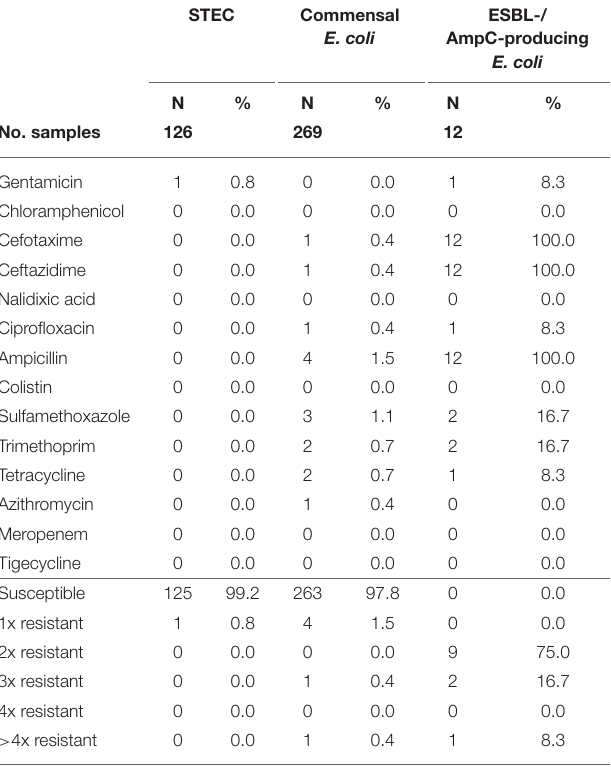
TABLE 6 | Number and proportion of tested resistant isolates from roe deer and TABLE 5 | Number and proportion of tested resistant isolates from wild boars and the number of substance classes to which the isolates were resistant. the number of substance classes to which the isolates were resistant. Salmonella STEC Commensal ESBL-/ STEC Commensal ESBL-/ E. coli E. coli spp. AmpC- producing E. coli